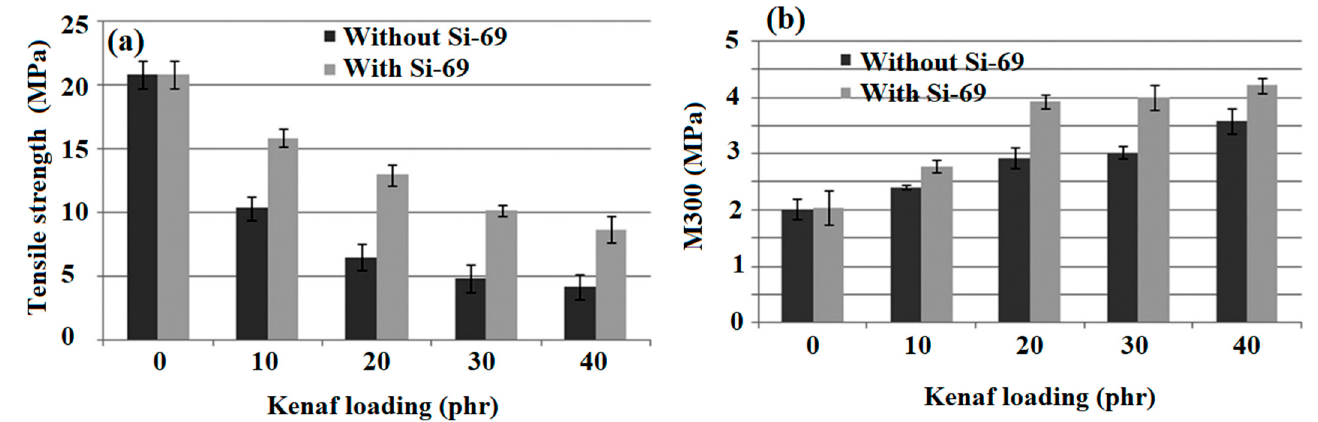
Figure 6. ( a ) Tensile strength and ( b ) modulus at 300% strain of kenaf fiber/NR composites before and after treatment with TESPT as a coupling agent (adapted with permission from [75]).